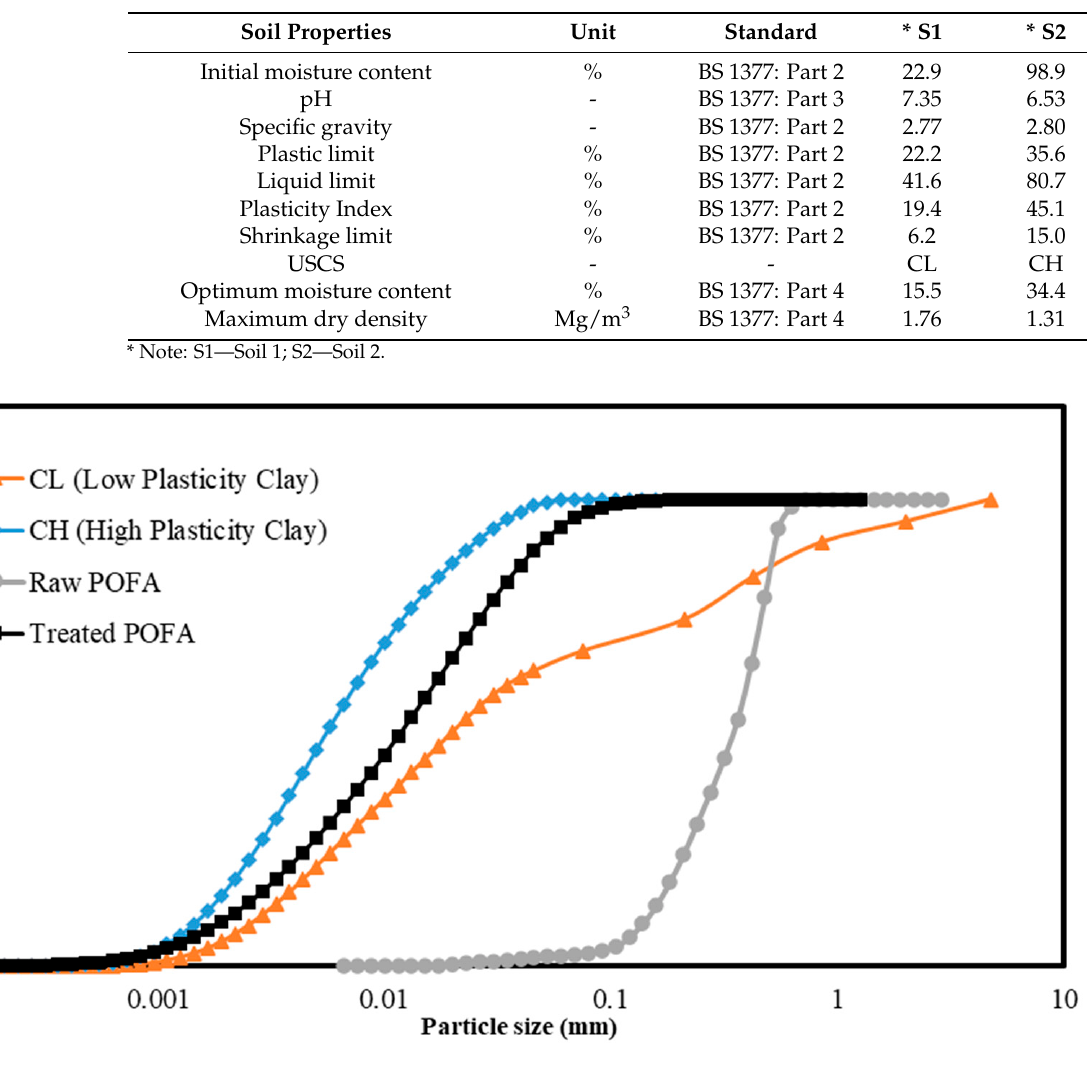
Figure 1. Particle size distribution S1 (low plasticity clay (CL)), S2 (high plasticity clay (CH)) and palm oil fuel ash (POFA).